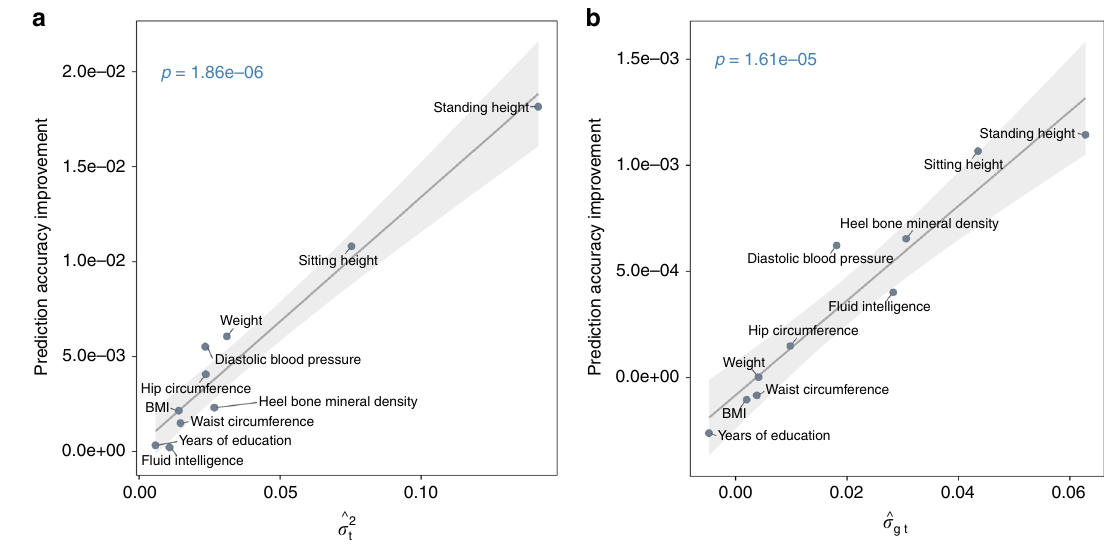
Fig. 2 Summary of fi ve-fold cross-validation results. Phenotypic prediction accuracy improves when accounting for the effects of the imputed transcriptome and the covariance between the effects of the genome and the imputed transcriptome. a The more the imputed transcriptome contributes to phenotypic variance, the greater the gain in phenotypic prediction accuracy. σ 2 denotes the phenotypic variance explained by the imputed transcriptome. t Prediction accuracy was computed using the Pearson ’ s correlation coef fi cient between the observed and the predicted for models with and without the imputed transcriptome component, denoted as y = g + t + ε and y = g + ε , respectively. g = the random effects of the genome; t = the random effects of the imputed transcriptome; ε = residuals. Prediction accuracy improvement (i.e., y -axis) was derived by subtracting the prediction accuracy of the model y = g + ε from that of the model y = g + t + ε . The least squares line is based on a linear model that regressed prediction accuracy improvement on phenotypic variance explained by the imputed transcriptome. The shaded area represents 95% con fi dence band based on s.e.m. A two-sided t -test (df = 8) was used to determine if the slope of the regression line differs from zero (see p -value on the left corner). b The larger the estimated covariance between the random effects of the genome and those of the imputed transcriptome (i.e., σ gt ), the greater the gain in phenotypic prediction accuracy. Prediction accuracy was computed using the Pearson ’ s correlation coef fi cient between the observed and the predicted for two models of the form y = g + t + ε , but one assuming σ gt = 0, i.e., GREML, and the other setting σ gt as a free parameter for estimation, i.e., CORE GREML. Prediction accuracy improvement was derived by subtracting the prediction accuracy of GREML from that of CORE GREML. The least squares line is based on a linear model that regressed prediction accuracy improvement on σ gt estimates. The shaded area represents 95% con fi dence band based on s.e.m. A two-sided t -test (df = 8) was used to determine if the slope of the regression line differs from zero (see p -value on the left corner). Source data are provided as a Source Data fi le.